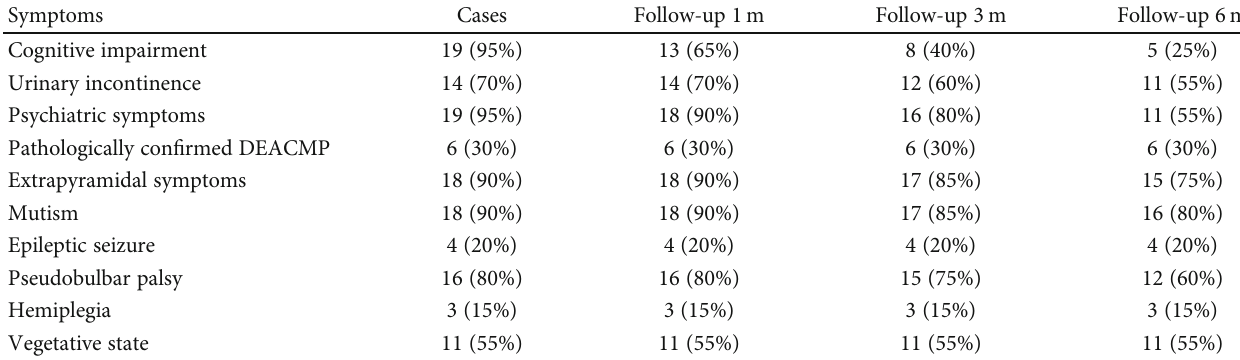
Table 1: Clinical characteristics and follow-up